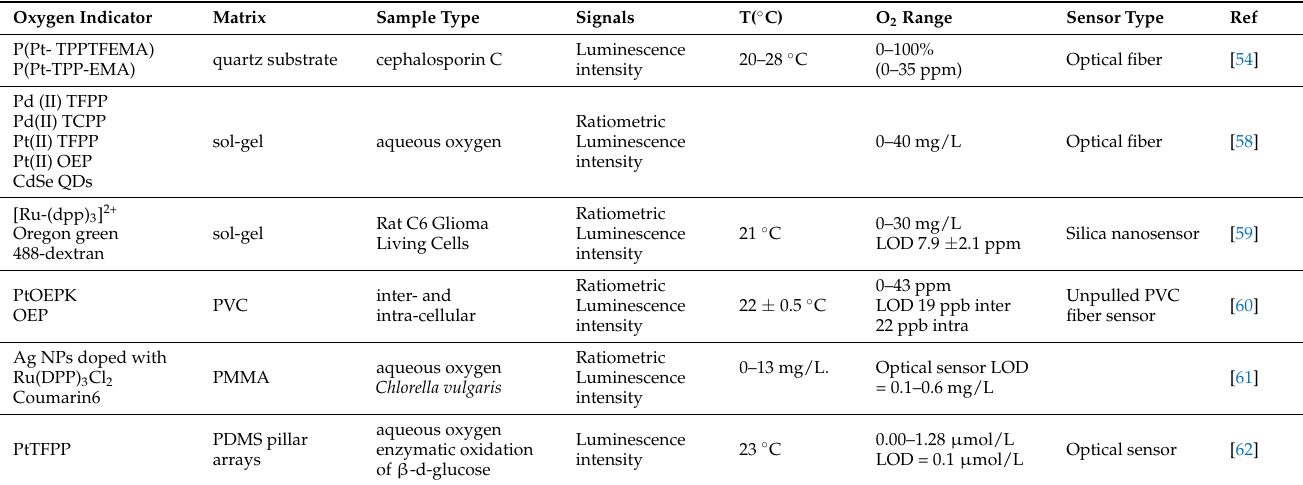
Table 1. Summary of available fluorescent oxygen